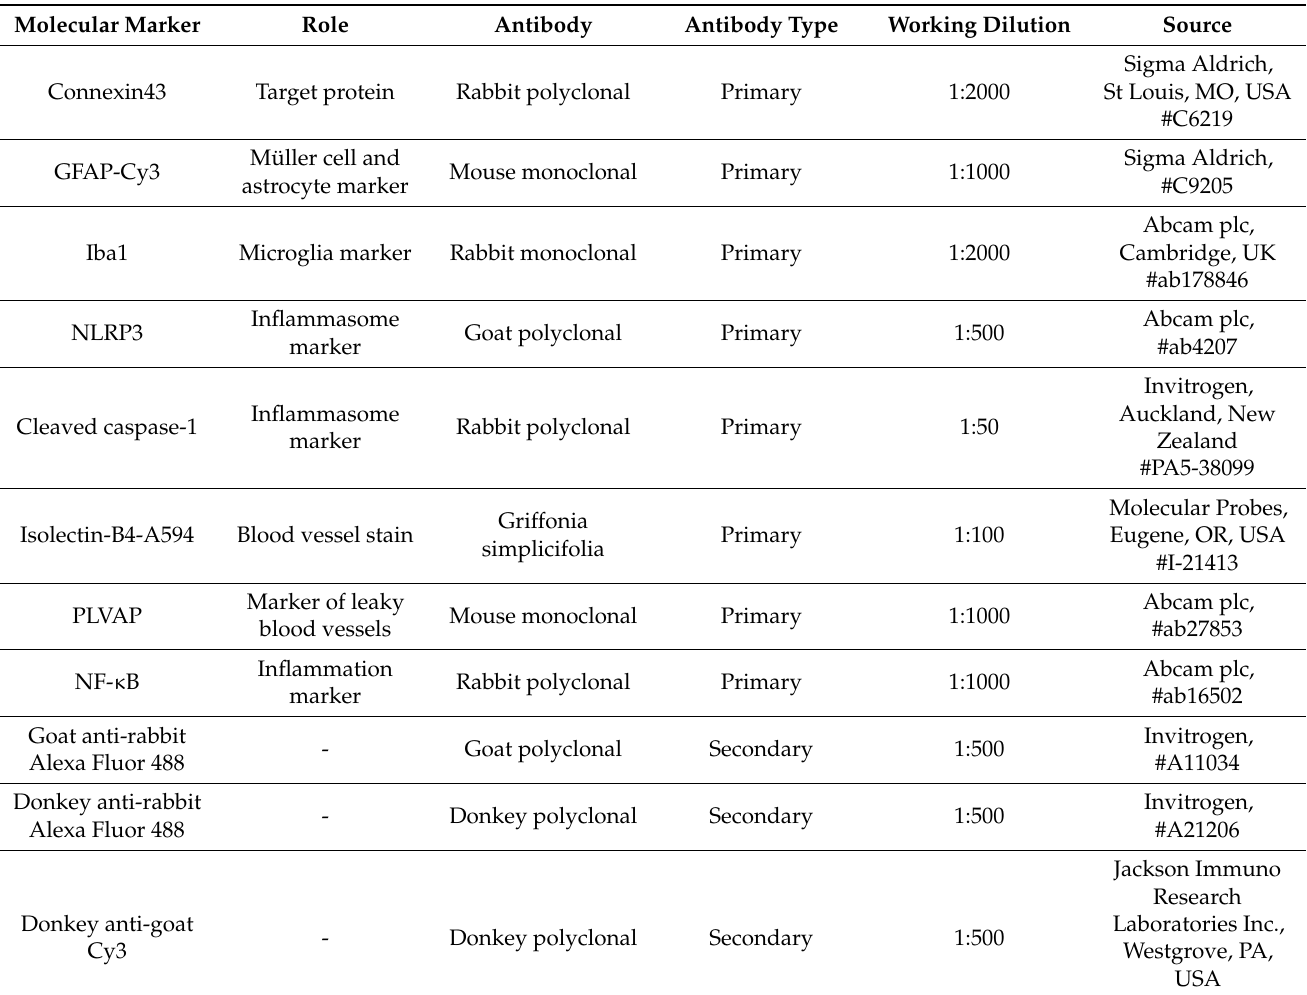
Table 2. Primary and secondary antibodies used in this